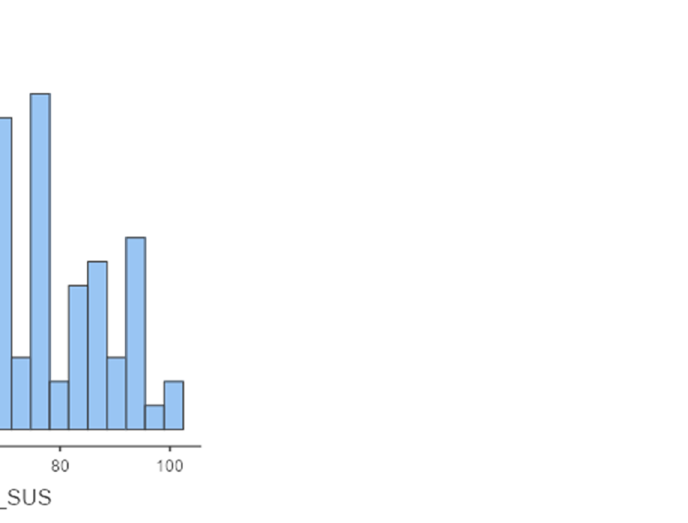
Figure 2. A graphic representation of SUS score’s distribution. The red line indicates cut-off of the SUS scale .